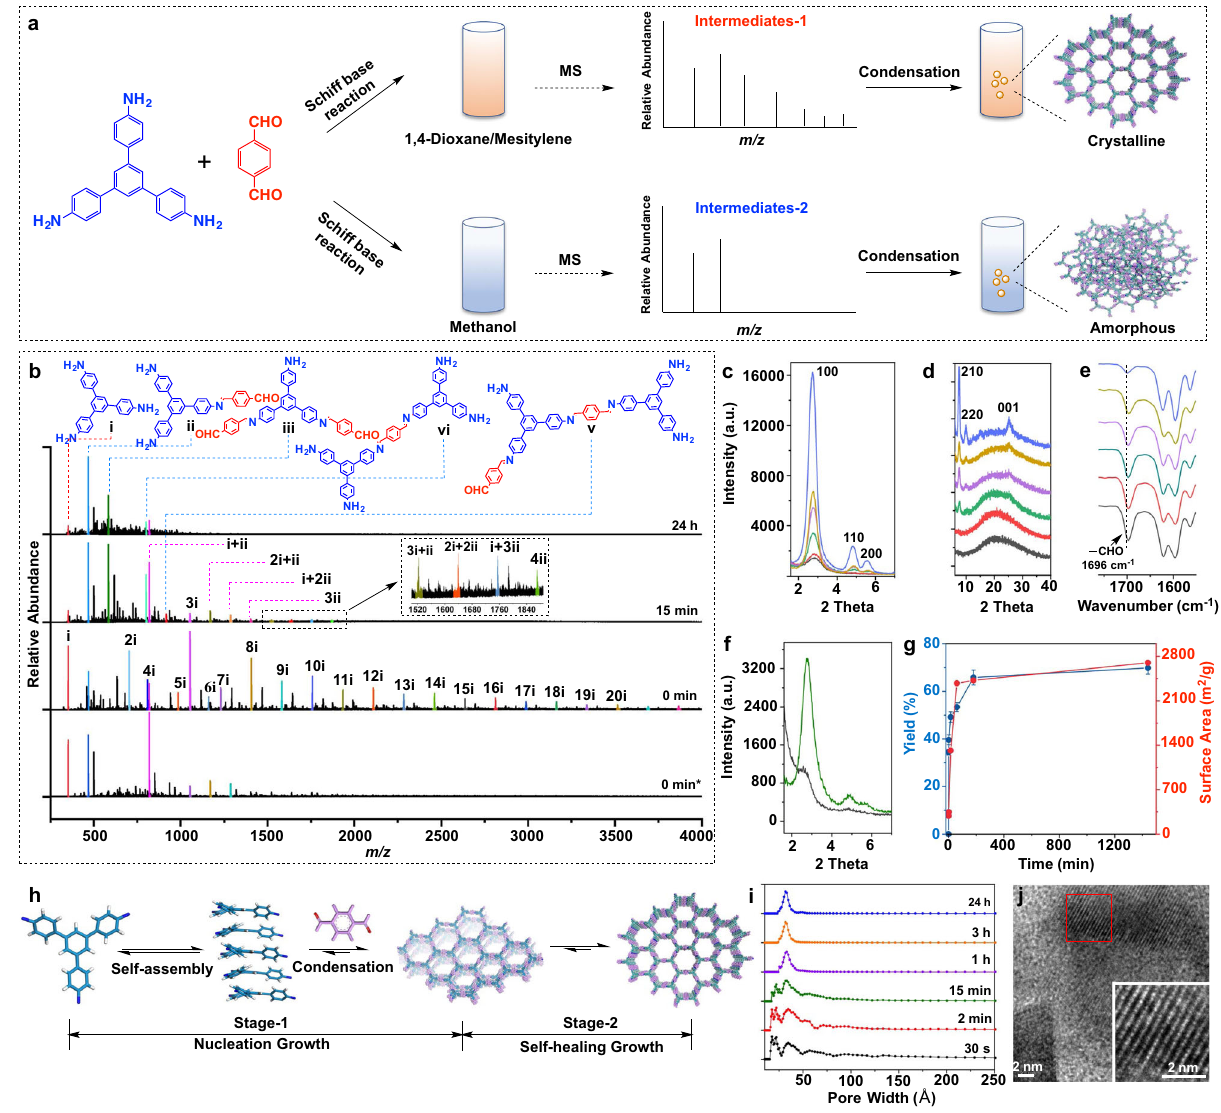
Fig. 1 Intermediate tracing study on the growth of TAPB-TA COF. a Scheme showing the molecular weight measurement of intermediate species in COF growth solutions by MS. b MS spectra of TAPB-TA growth solution using methanol versus 1,4-dioxane/mesitylene mixture as the solvent; *MS spectra taken from methanol growth solution. Quantitative PXRD patterns of the TAPB-TA with different growth time, 2 θ value ranging from ( c ) 1.8° to 7.0°, and ( d ) 7.0° to 40°; growth solvent: 1,4-dioxane/mesitylene; growth time: 30 s (black), 2 min (red), 15 min (green), 1 h (purple), 3 h (orange), and 1 day (blue). e FTIR spectra of TAPB-TA with growth time of 30 s (black), 2 min (red), 15 min (green), 1 h (purple), 3 h (orange), and 1 day (blue). f Quantitative PXRD patterns of TAPB-TA with 15 min growth time in methanol (black) versus 1,4-dioxane/mesitylene (green). g Yield and surface area of the TAPB-TA products versus growth time. h Scheme showing the two stages that exist in the growth of TAPB-TA COF. i Pore size distribution of TAPB-TA products with different growth time. j TEM image of the TAPB-TA grown in 30